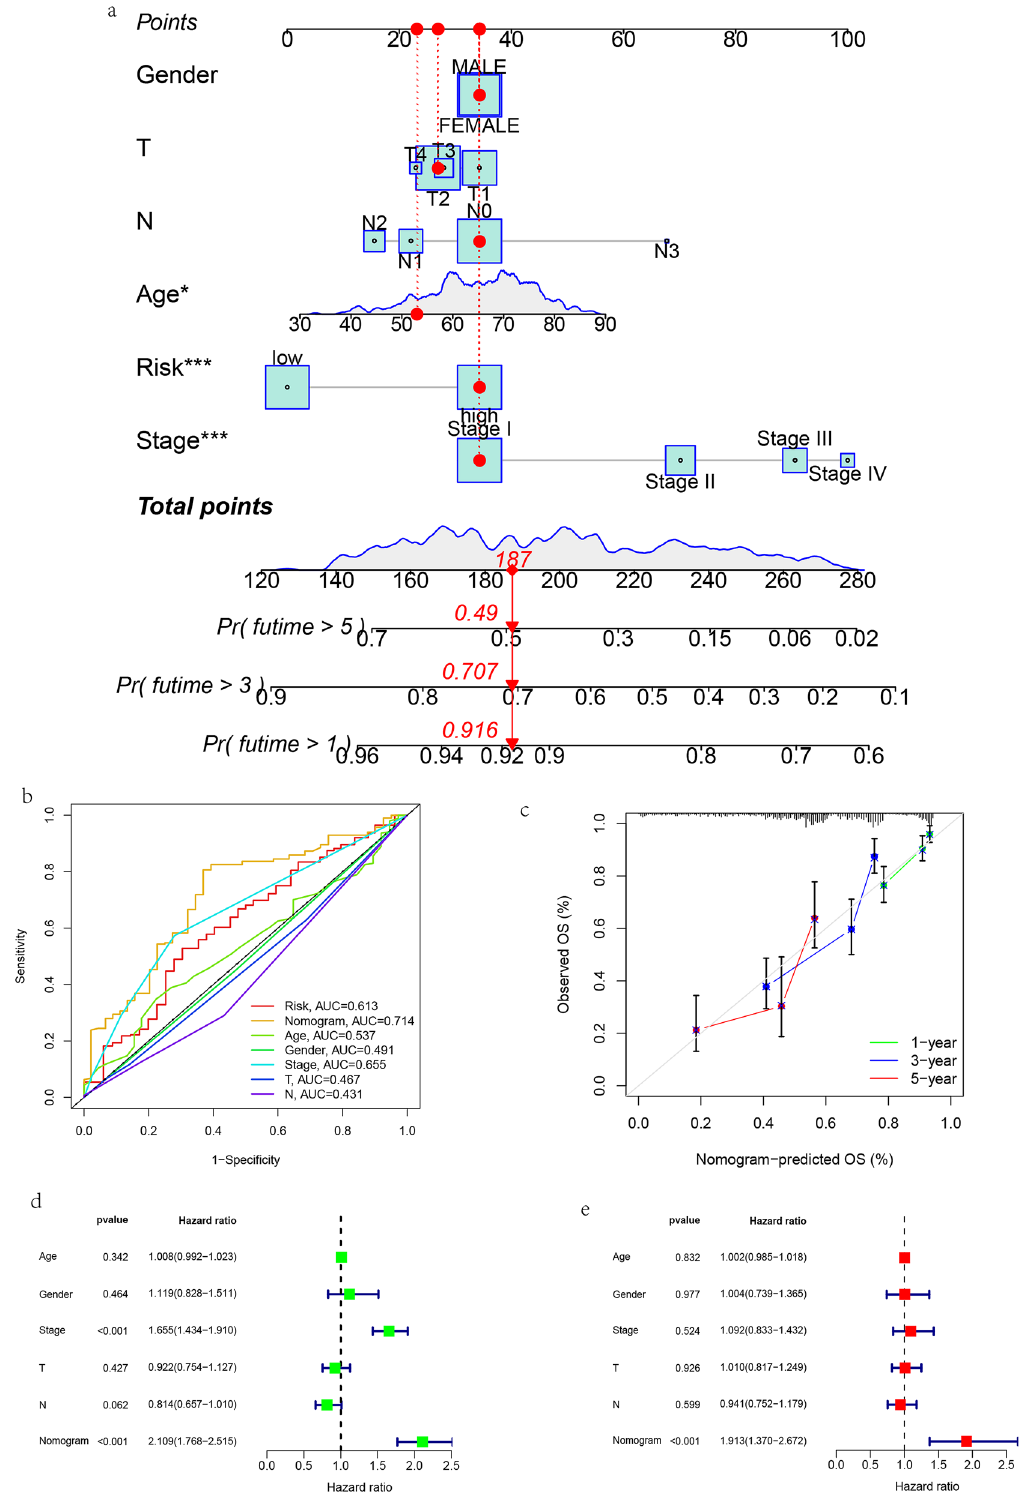
Figure 7. Construction of nomograms. ( a ) Nomograms used to predict the 1, 3, and 5-year overall survival of lung adenocarcinoma (LUAD) patients in the The Cancer Genome Atlas (TCGA) cohort. ( b ) Calibration chart for predicting recurrence in 1, 3 and 5 years. ( c ) Receiver operating characteristic (ROC) curve evaluates the sensitivity of nomograph model. ( d ) Univariate Cox regression analysis in TCGA cohort. ( e ) Multivariate Cox regression analysis in TCGA